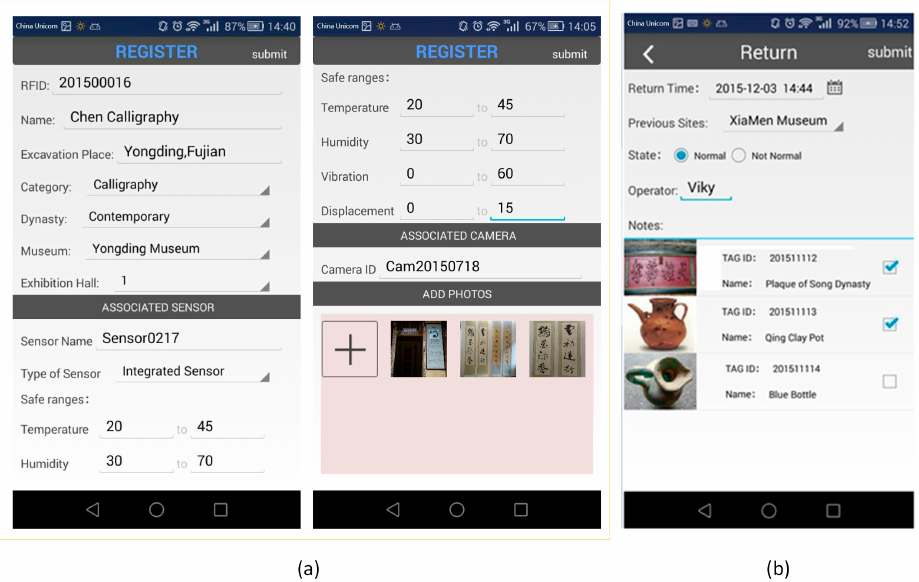
Figure 11. Management results of the application scenario: ( a ) Initial registration of cultural relics; ( b ) Circulation management for cultural relics (the Return operation is shown here as an example).